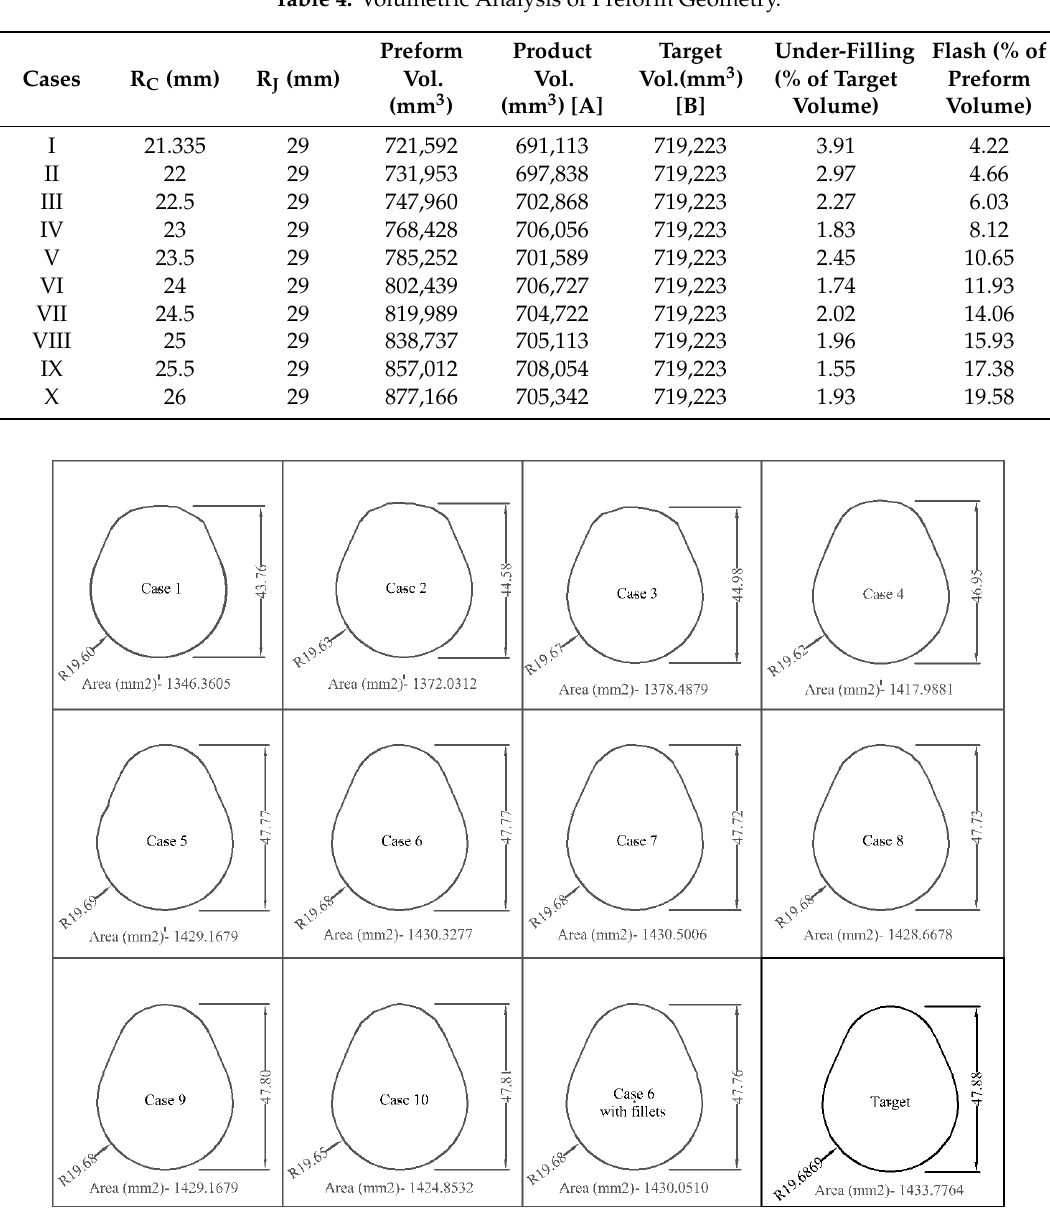
Figure 6. Gradual Improvement of Profile of CAM.